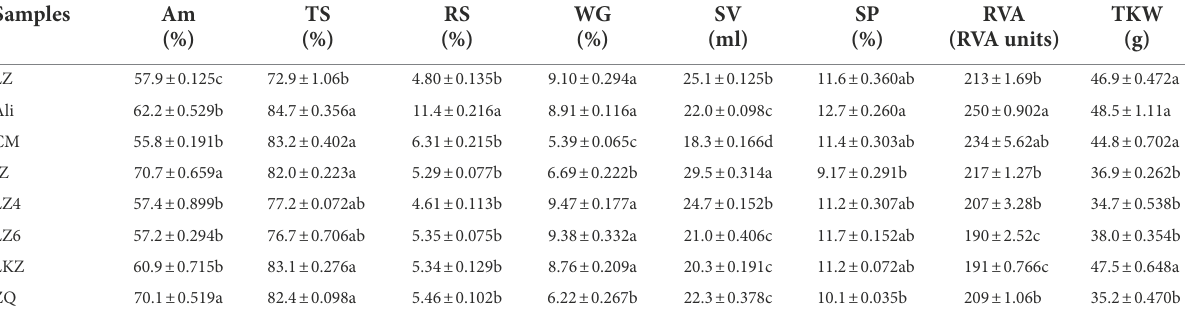
TABLE 1 The properties of the eight HB varieties from Tibet Plateau,